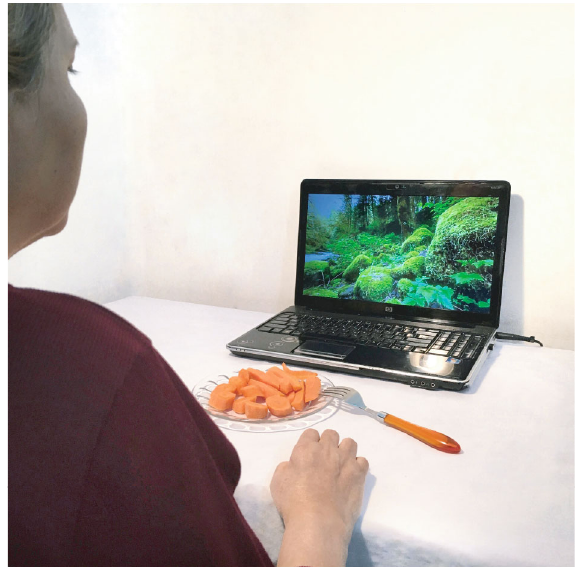
Figure 3: A right hemiplegic patient in control group watching landscape (sham)